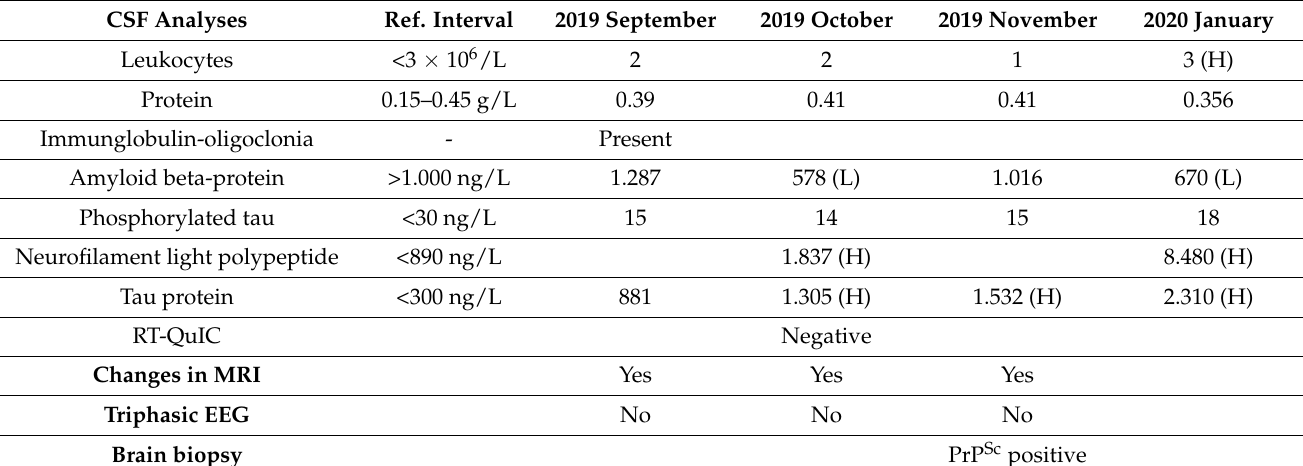
Table 2. Overview of the performed paraclinical